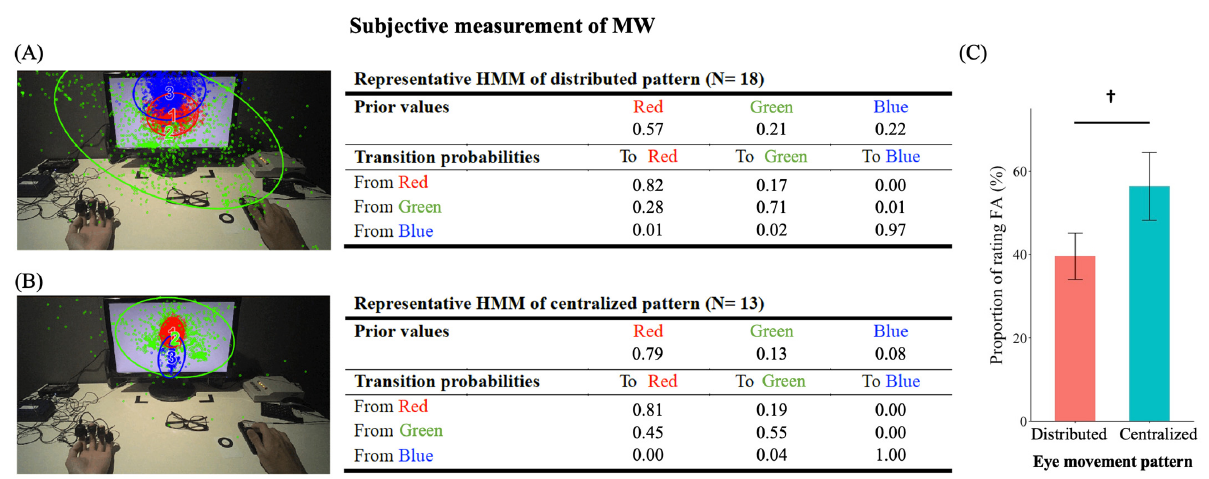
Figure 5. The two representative eye movement patterns during the 10-s pre-probe period for ( A ) the distributed eye movement pattern and ( B ) the centralized eye movement pattern. The tables in the middle panel show the transition matrix. Prior values refer to the probability of the first fixation of a trial landed at a specific ROI. ( C ) The proportion of rating focused attention (FA) for participants with the two eye movement patterns as a subjective measurement of MW. Error bars represent one S.E.M. † p < 0.1.